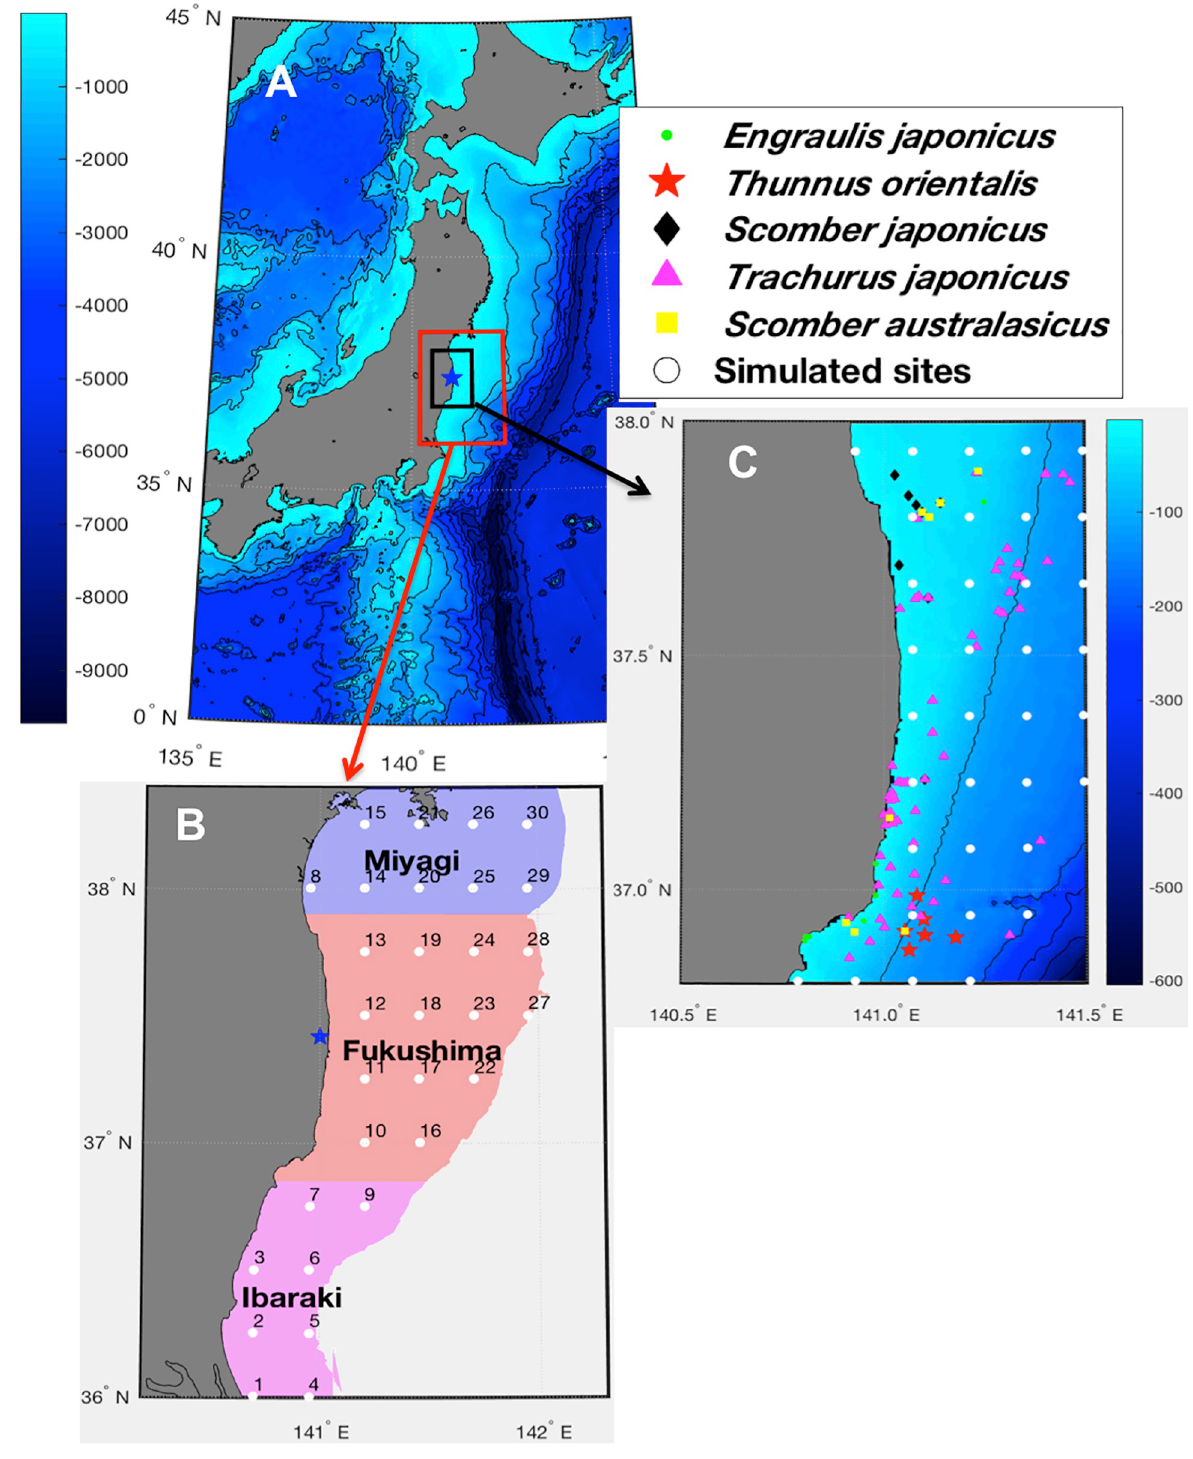
Fig 3. (A) Map of Japan showing the location of the study area in the Pacific coast. (B) Positions of the 30 simulated sites (numbered from 1 to 30) used for the validation of the model in the case of the non-georeferenced data. (C) zoom of the area with a higher spatial resolution, showing the positions of the sites used for the validation of the model in the case of the georeferenced data.